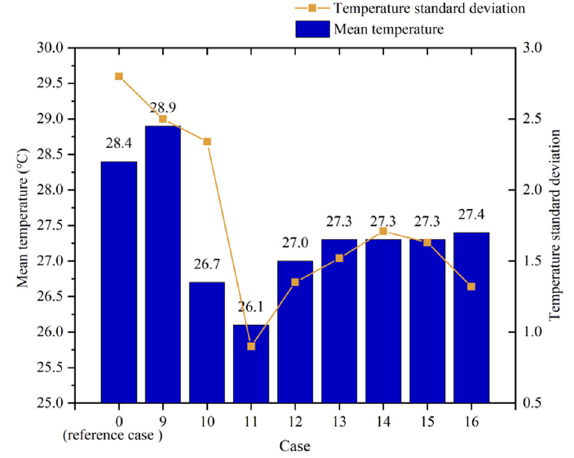
Figure 15. The average air temperatures of the back door in case 0 and cases 9–16.